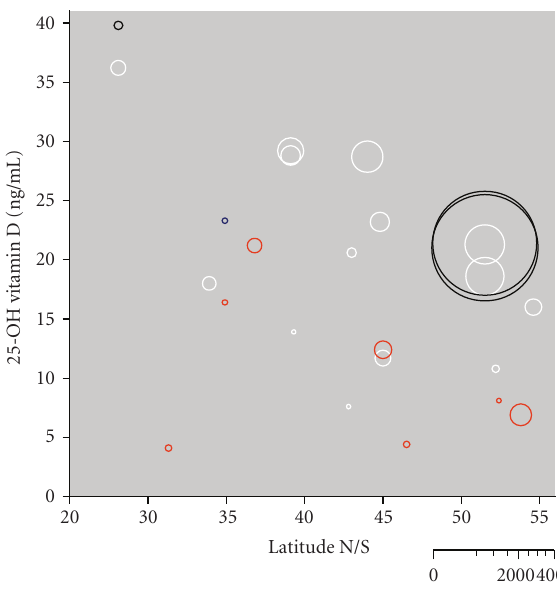
Figure 1: 25-OH vitamin D levels in pain subjects and nonpain controls according to latitude (northern or southern hemisphere). White circles indicate pain subjects from the general Western population; black circles indicate nonpain (control) subjects from the general population. Red circles show data for pain subjects from immigrant/ethnic minority populations and the blue circle is from an ethnic minority nonpain control population. The size of the symbol is proportional to the size of the study populations (inset logarithmic